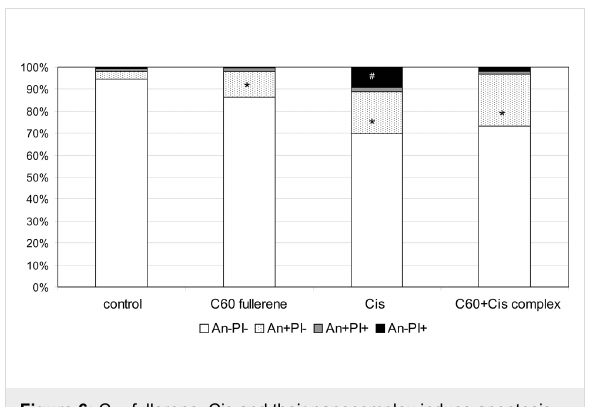
Figure 6: C 60 fullerene, Cis and their nanocomplex induce apoptosis as well as necrosis of lymphocytes from healthy persons. Cells were treated with mentioned compounds at the concentration of 0.15 mg/mL for 24 h. After culturing, cells were stained with annexin V (AnnV)/ propidium iodide (PI) and analyzed by flow cytometry. Control: cells were incubated without any additional agents. The average values for four independent experiments are presented. * p < 0.05 compared with untreated cells; # p < 0.05 compared with cells treated with C 60 +Cis